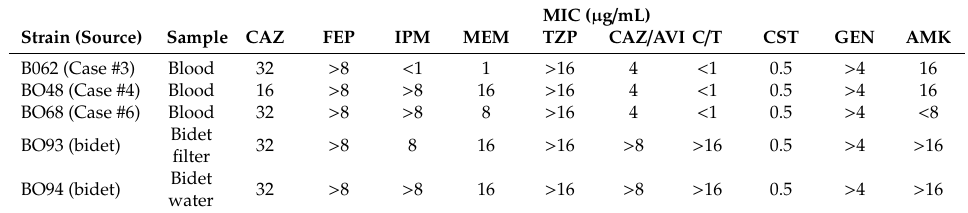
Table 2. Phenotypic characteristics of Pseudomonas aeruginosa strains isolated from patients and the environment.